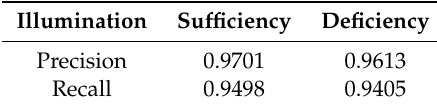
Table 6. The effect of illumination on our proposed method.